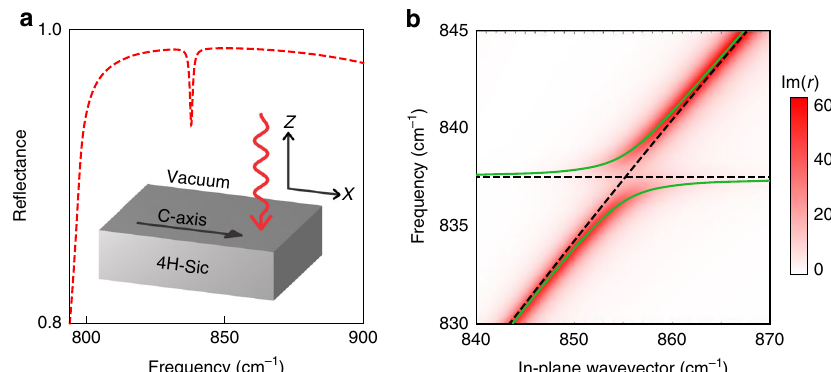
Fig. 2 Coupling between a ZFLO and a SPhP resonance at the interface of a polar dielectric halfspace. a TM polarised re fl ectance calculated for an a-cut, 4H-SiC substrate supporting a weak phonon mode at near normal incidence. The in-plane wavevector of the incident light is parallel to the crystal c -axis. The inset illustrates the physical system under study. b Colormap illustrates the dispersion of the surface phonon polariton on the bilayer interface calculated by Eq. (4). Overlaid dashed lines indicate the bare weak phonon and surface phonon polariton dispersions, while the green curves illustrate